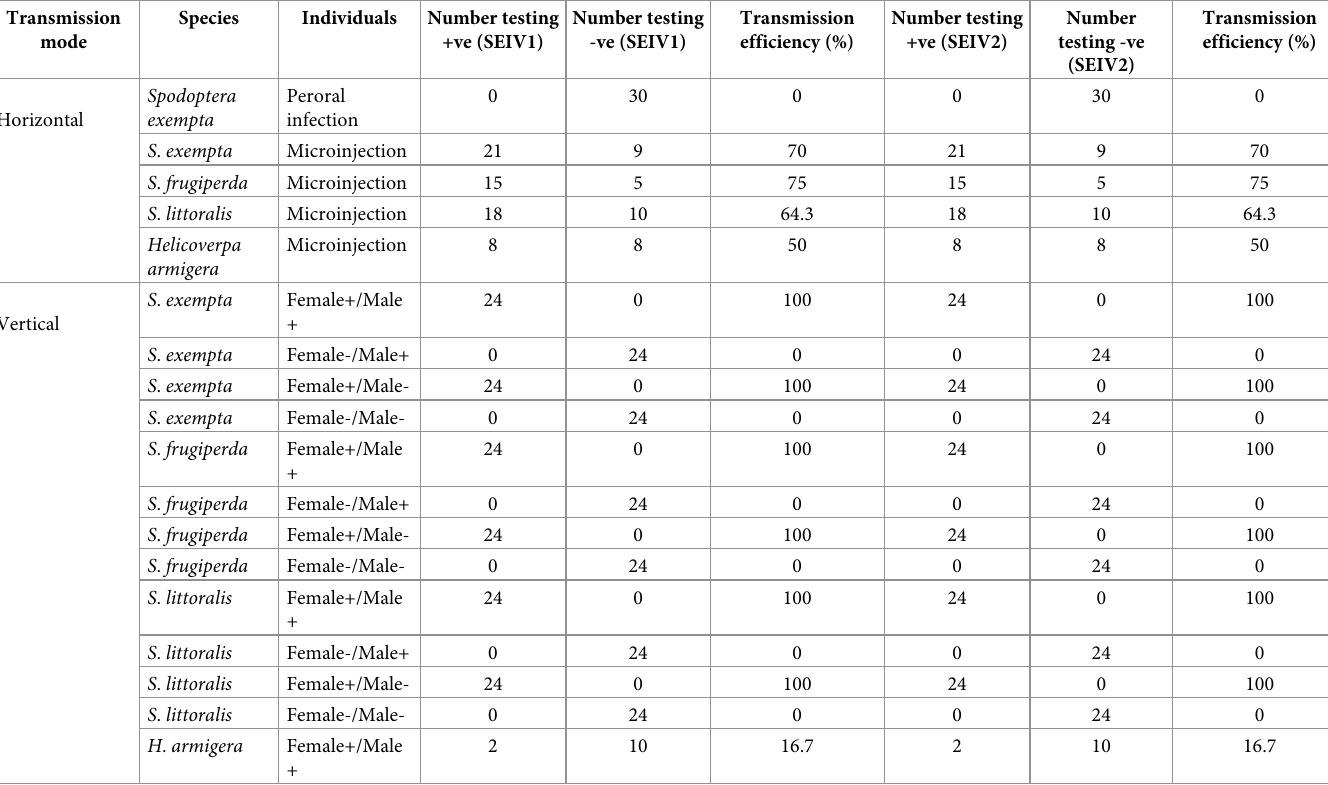
Table 1. Transmission mode of SEIV1 and SEIV2. Infected individuals = “+”, uninfected individuals = “-”. Transmission